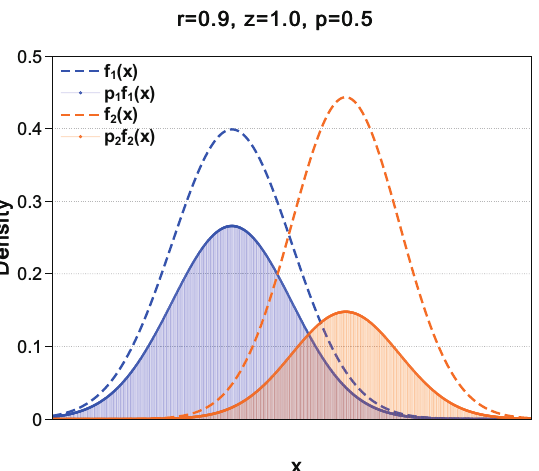
Figure 5. Schematic diagram of the probability density distribution of x when r = 0.9, z = 1.0, p = 0.5 . The horizontal coordinate axis is x , while the vertical coordinate axis is the probability density. Blue and orange dashed lines are curves of function f 1 ( x ) and f 2 ( x ) , respectively, while the blue and orange solid lines are curves of function p 1 f 1 ( x ) and p 2 f 2 ( x ) , respectively. The areas of the blue and orange regions are integrals of f 1 ( x ) and f 2 ( x ) ,